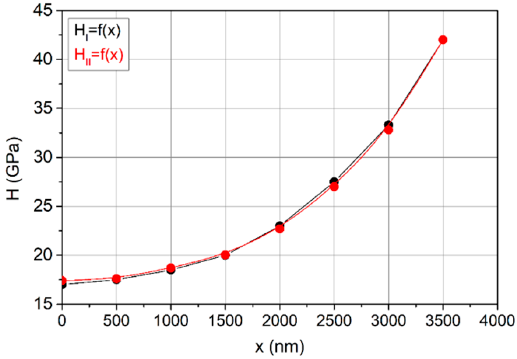
Figure 6. Comparison of profiles of hardness changes in coatings determined on the basis of parabolic carbon content profiles determined in the range of 0–50 at.% and 50–85 at.%.